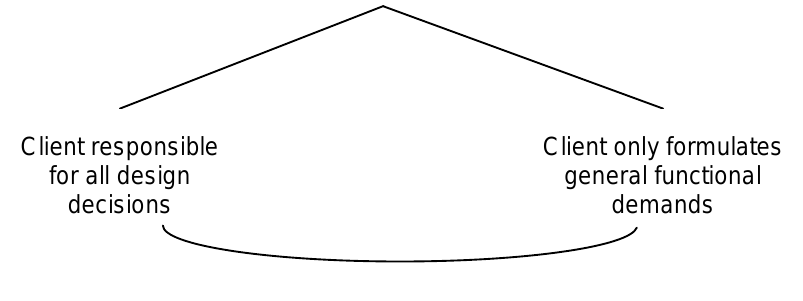
Figure 3: Step 2, Version 2: Who will do the design? (Source: